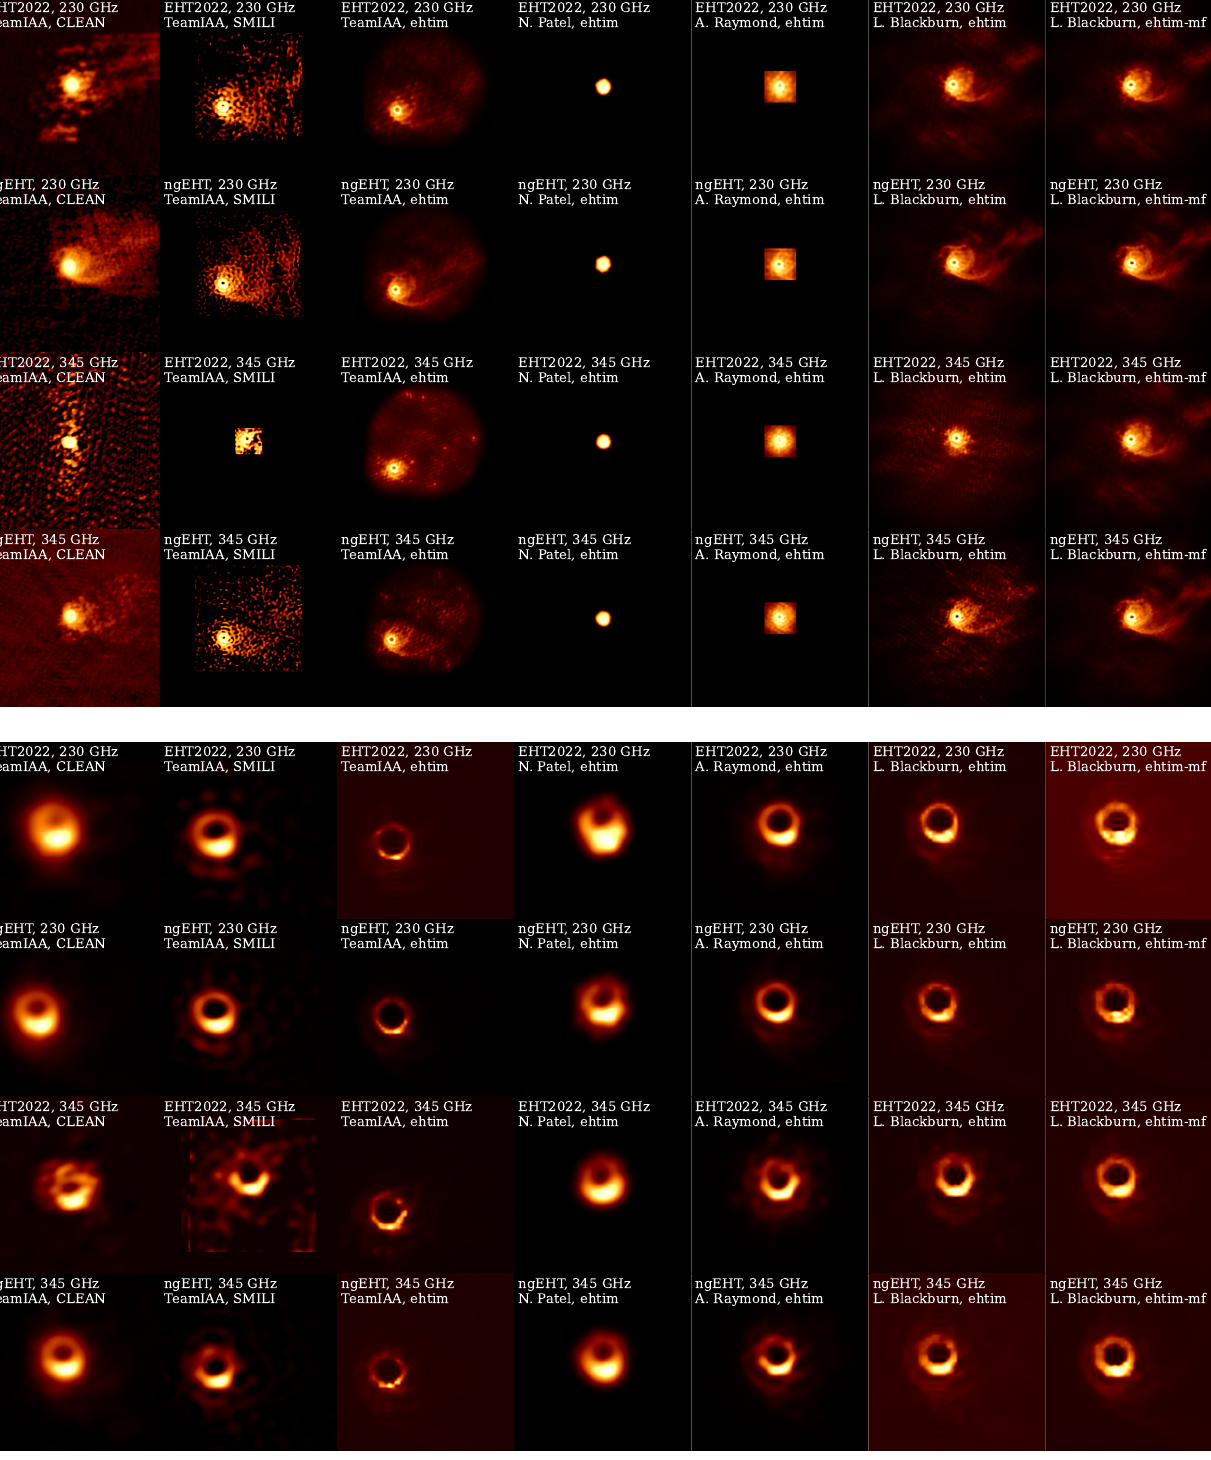
Figure 4. M87 reconstructions submitted for Challenge 1. Images are shown on a log scale with a 1 mas field of view in the top set of panels. The same images are shown on a linear scale with a 200 µ as field of view in the bottom set of panels. All M87 reconstructions recover the black hole shadow, whereas the jet features are only recovered by some. The low surface brightness structure in the M87 jet is already visible in some EHT2022 reconstructions. The jet reconstructions improve significantly with ngEHT1 coverage, as attested by both visual inspection of the images and the